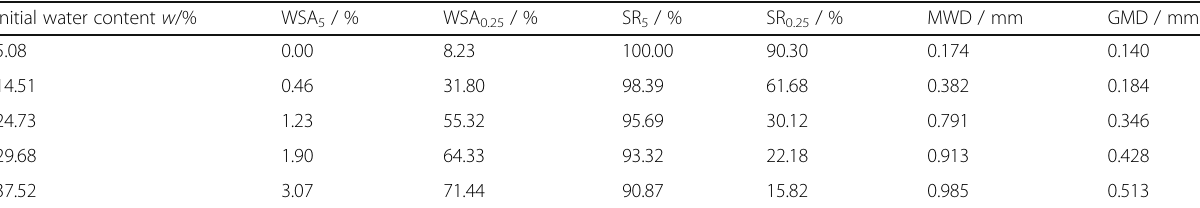
Table 5 Characteristic parameters of soil aggregates under different initial water contents Initial water content w /% WSA 5 / % WSA 0.25 /